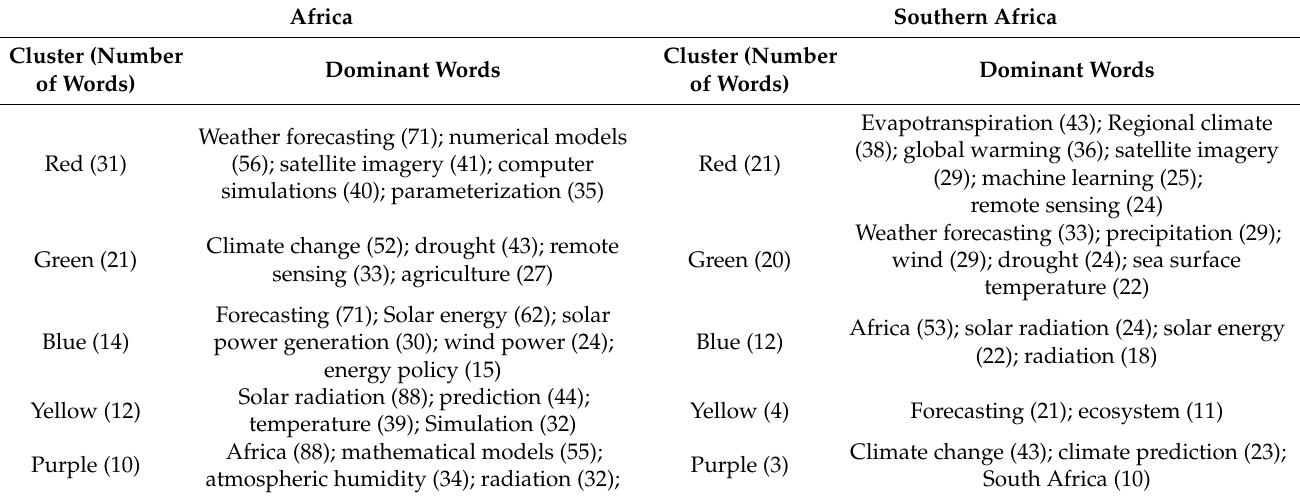
Table 5. A summary of the most frequent